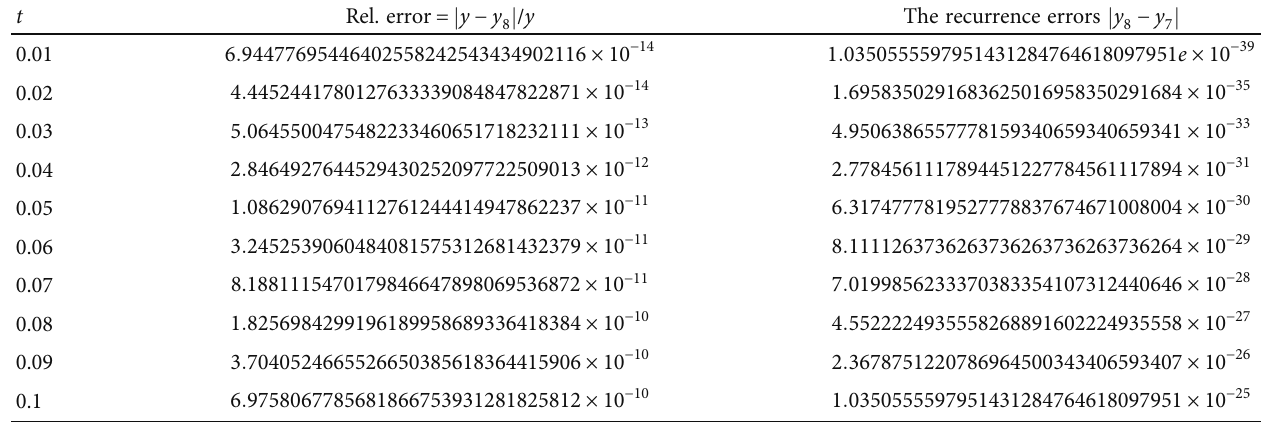
Table 12: Relative error = j y − y Example